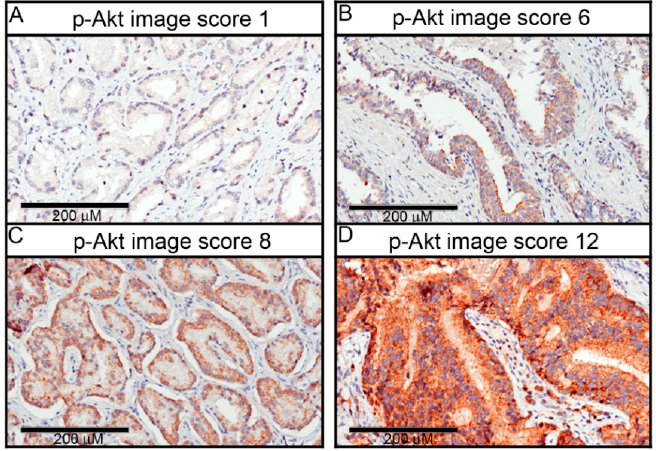
Figure 1. Cont. Figure 1.